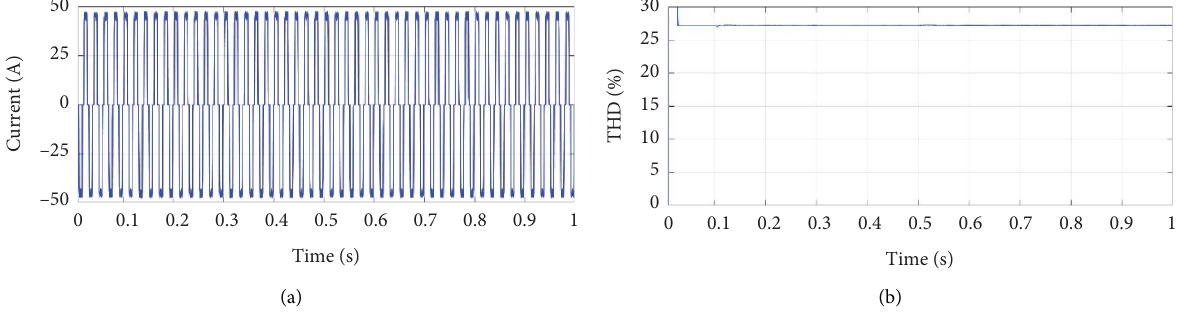
Figure 8: Load current (a) and its THD (b).